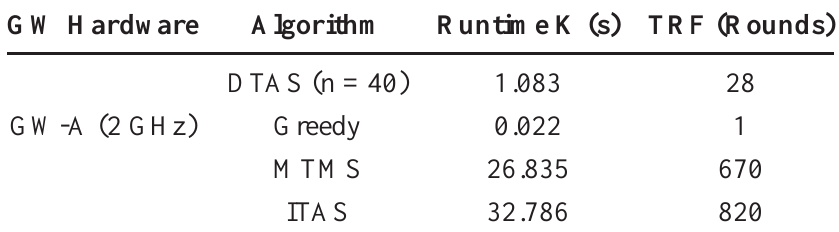
Table 2. Algorithm runtime comparison. GW, gateway; DTAS, Dynamic Task Allocation and Scheduling; TRF, Task Reallocation Frequency.